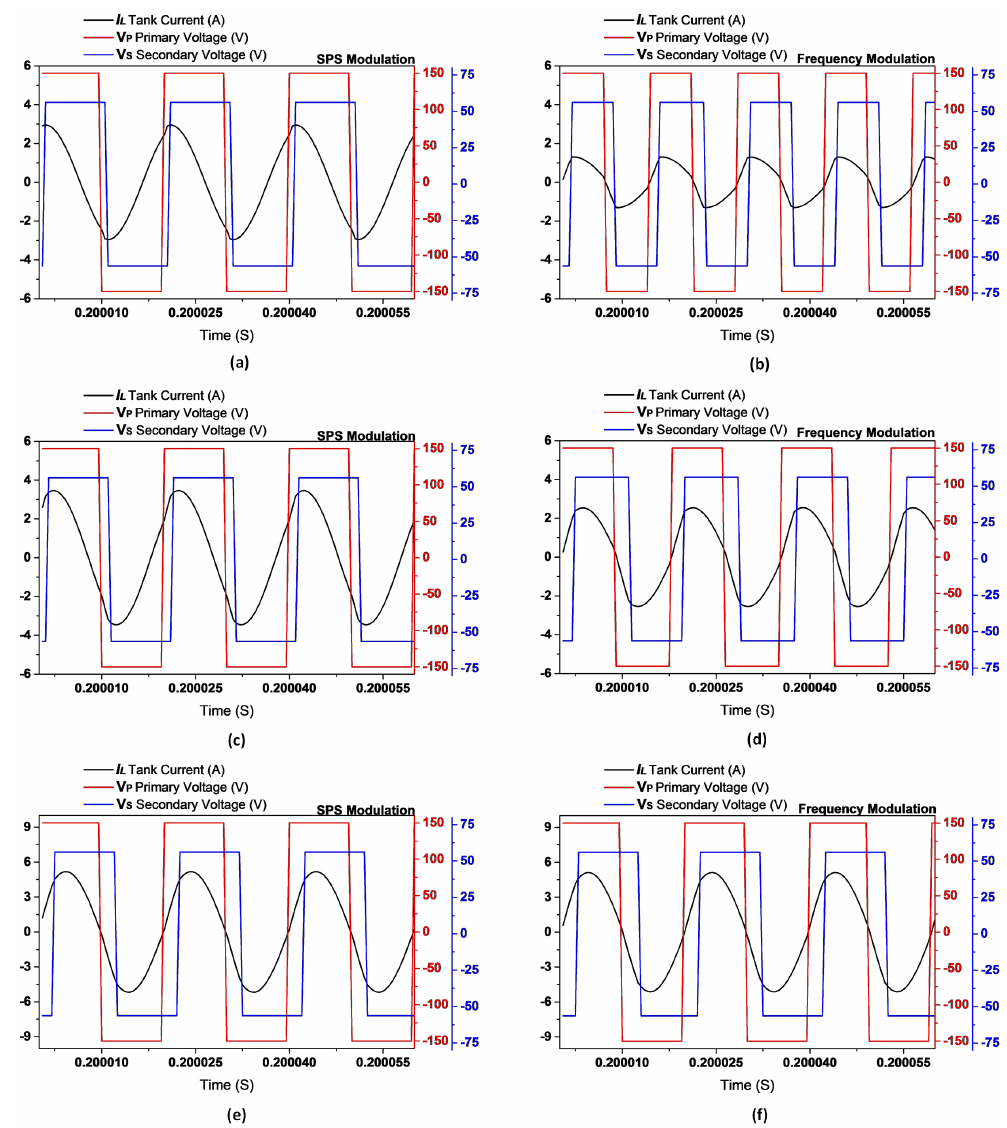
Figure 21. Simulated waveform at a voltage gain of M = 1.5: ( a ) 25% rated power using SPS modulation; ( b ) 25% rated power using frequency modulation; ( c ) 50% rated power using SPS modulation; ( d ) 50% rated power using frequency modulation; ( e ) 100% rated power using SPS modulation; ( f ) 100% rated power using frequency